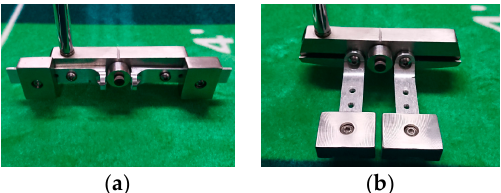
Figure 4. Adjustable putter used for physical testing. ( a ) Configuration A ( (cid:1870) (cid:3030)(cid:3052) = 11.2 mm, (cid:1835) (cid:3030)(cid:3053) = 3997 g cm (cid:2870) , (cid:1865) (cid:3030) = 360 g ); ( b ) Configuration B ( (cid:1870) (cid:3030)(cid:3052) = 25.2 mm,(cid:1835) (cid:3030)(cid:3053) = 4790 g cm (cid:2870) , (cid:1865) (cid:3030) = 360 g